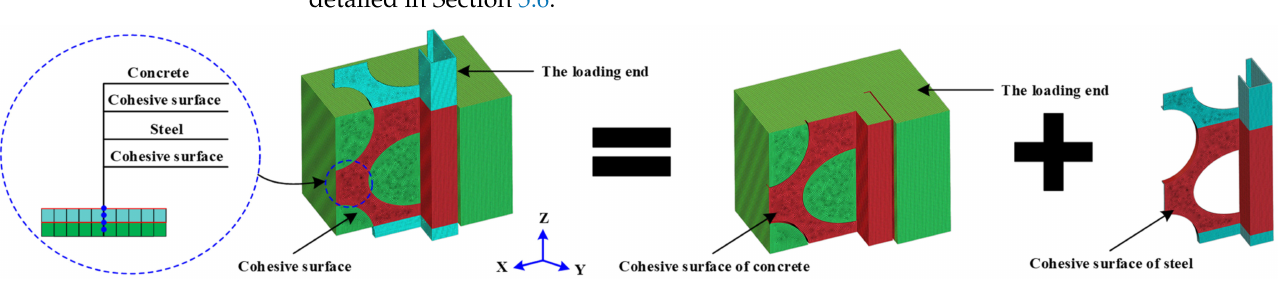
Figure 18. Contact details of the FE model.